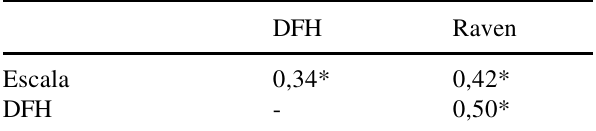
Figure Drawings as measures of intelligence: The comparative validity of three scoring systems. Journal of Psychoeducational Assessment , 19 (3), 204-215.